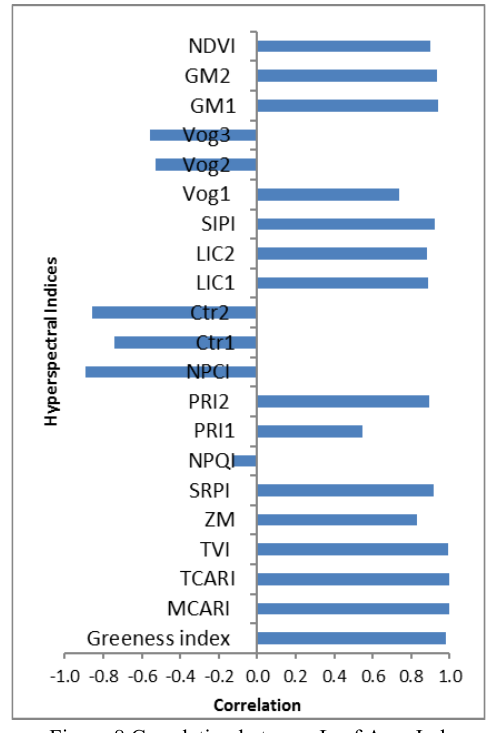
Figure 8 Correlation between Leaf Area Index and Hyperspectral indices Bandwidths of 528-531 nm, 550-570 nm, 710-760 nm, and single bands such as 800 nm and 920 nm and indices